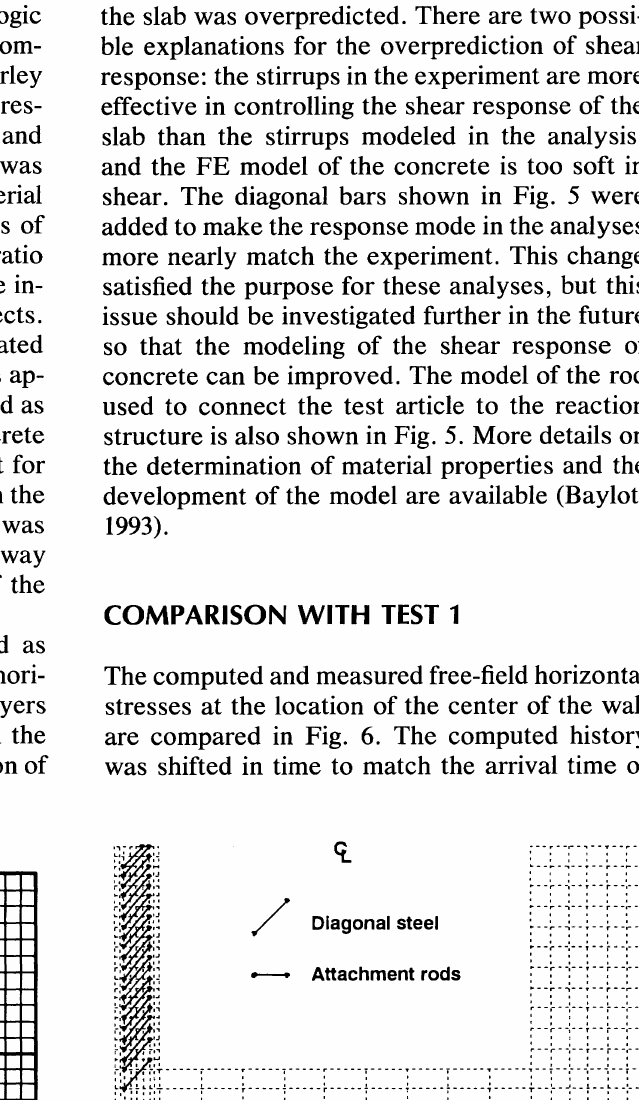
FIGURE 3 Grid outline.